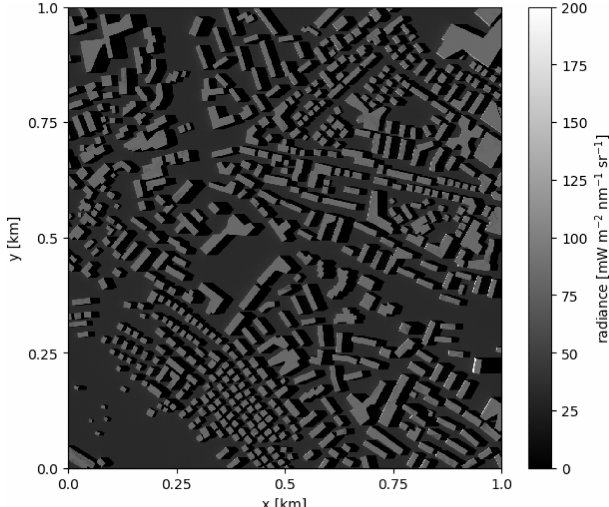
Figure 3. Radiance seen by a downward-viewing instrument placed in the center of the 1km × 1km region at an altitude of 6km. SZA and SAA are 60 and 90 ◦ , respectively.